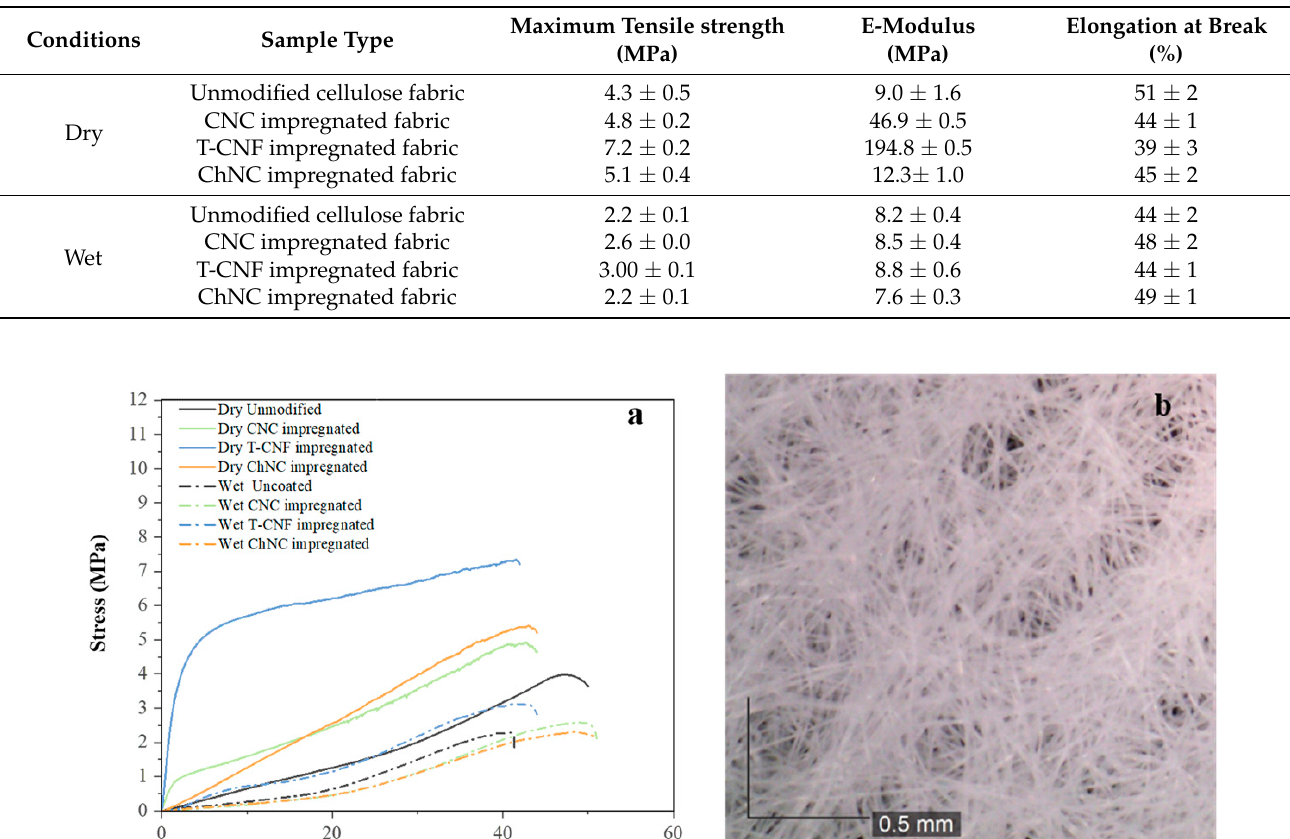
Table 2. Summary of mechanical properties for uncoated and impregnated membranes.